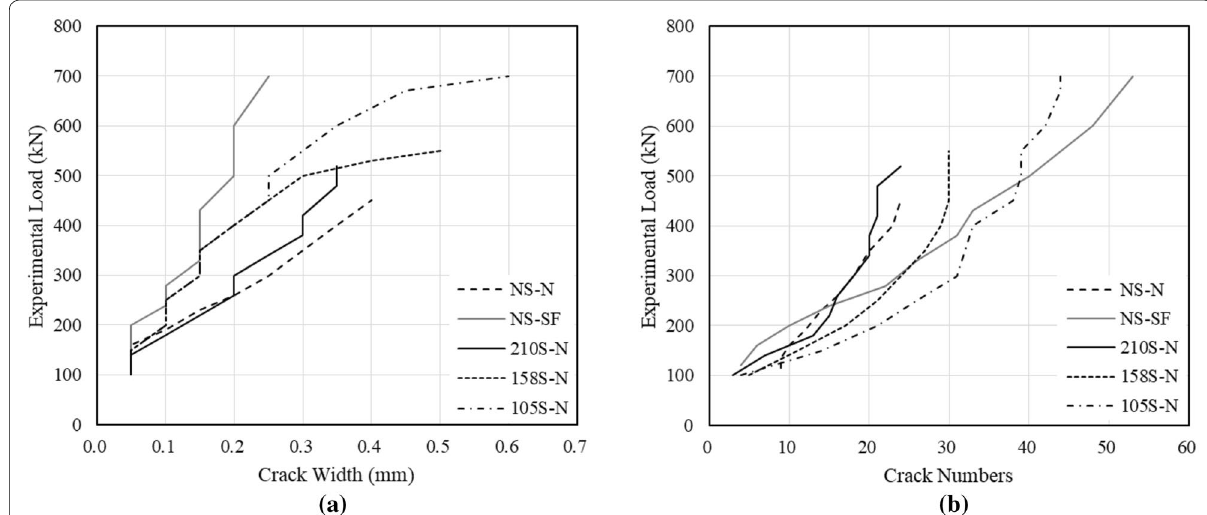
Fig. 10 Shear load relative to crack width and numbers; a crack width, and b crack numbers.